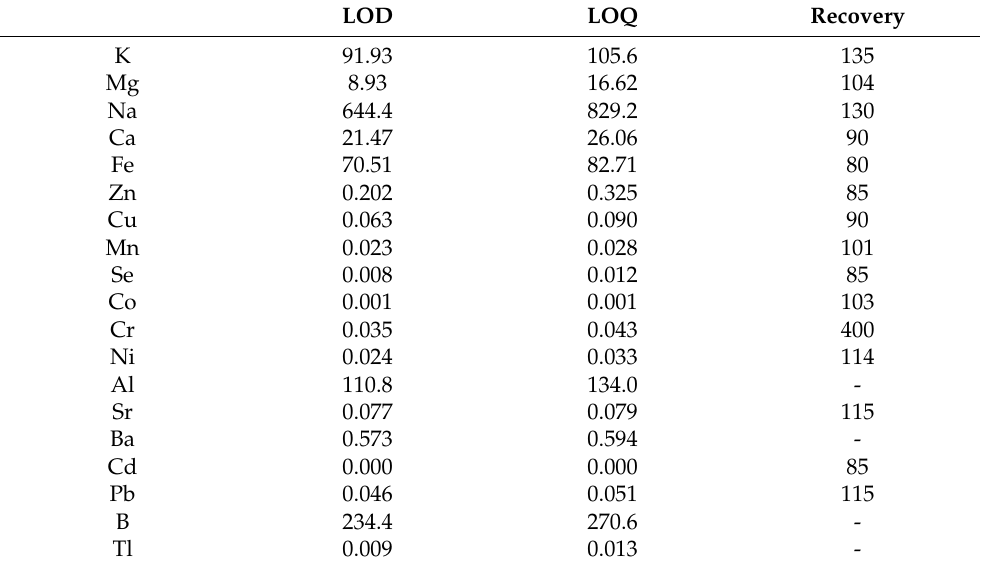
Table 7. Values of limit of detection (LOD) (mg/kg), limit of quantification (LOQ) (mg/kg) and recovery (%) of detected